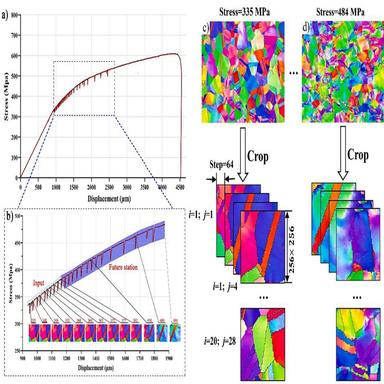
Training data pre-processing. (a)-(b) stress-displacement tensile curve of Inconel718 alloy; (c)-(d) data preparation.